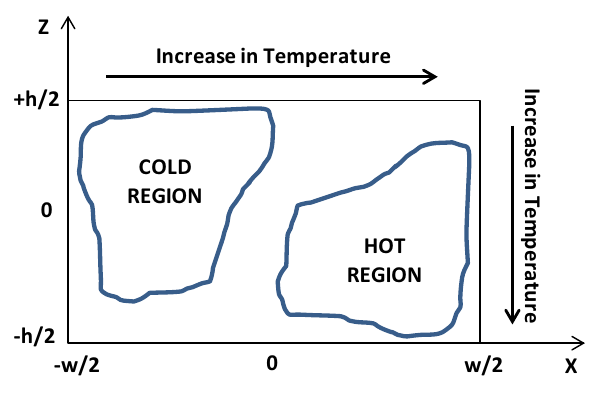
Fig. 1 Schematic of the geometry selected for this